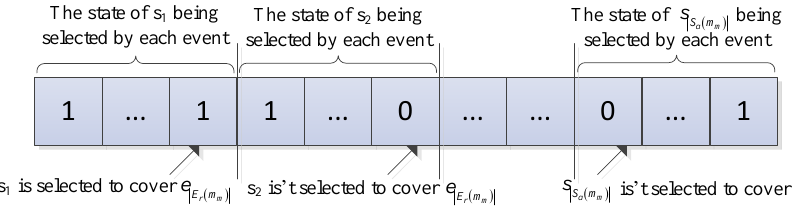
Figure 6. Solution encoding figure.